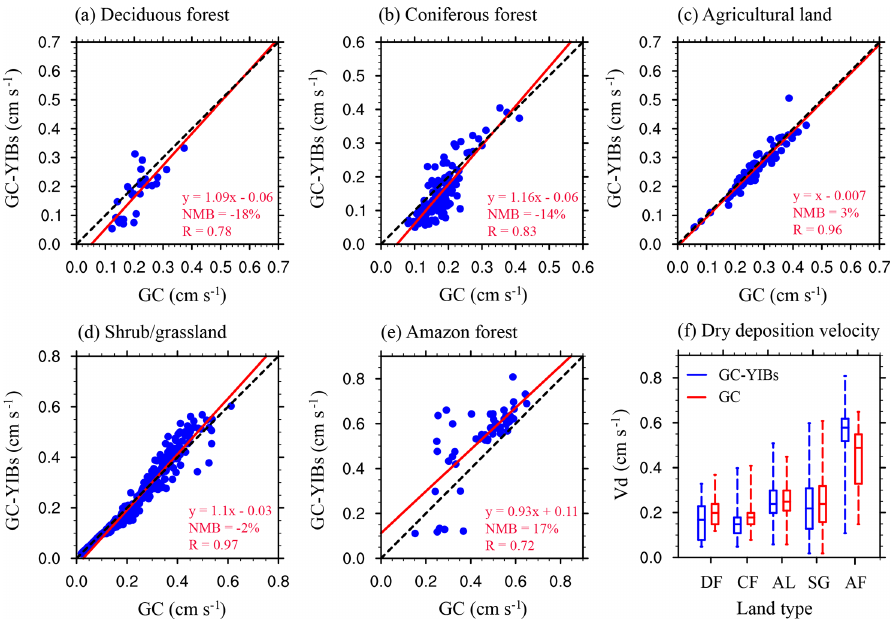
Figure 6. Comparisons of annual O 3 dry deposition velocity between online GC-YIBs (Online_ALL simulation) and GC (Offline simulation) models for different land types, including (a) deciduous forest (DF), (b) coniferous forest (CF), (c) agricultural land (AL), (d) shrub/grassland (SG), and (e) Amazon forest (AF). The box plots of dry deposition velocity simulated by online GC-YIBs (blue) and GC models (red) for different land types are shown in (f) . Each point in (a–e) represents annual O 3 dry deposition velocity at one grid point averaged for the period of 2010–2012. The red lines indicate linear regressions between predictions from GC-YIBs and GC models. The regression fit, correlation coefficient ( R ), and normalized mean biases (NMBs) are shown in each